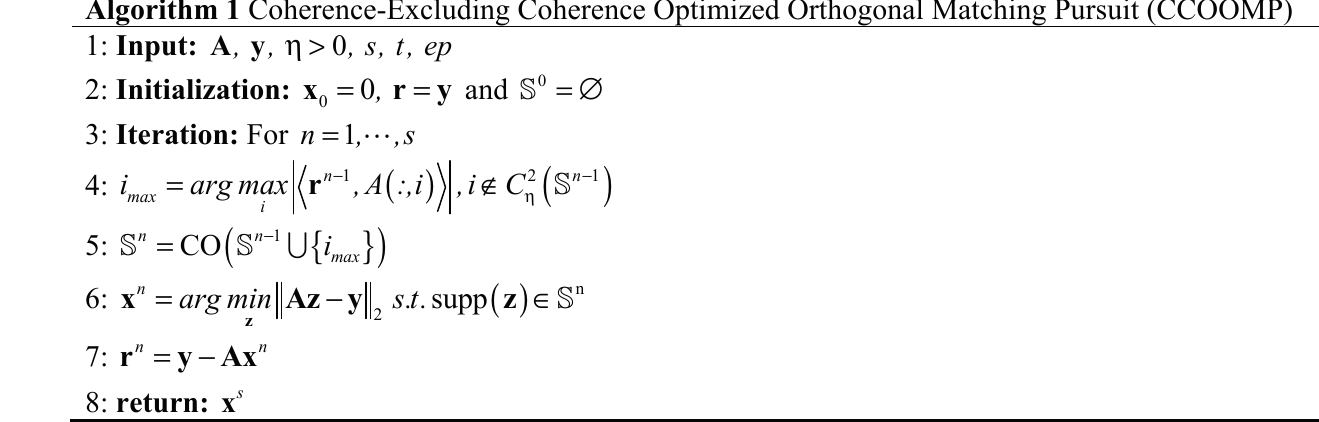
Algorithm 1 Coherence-Excluding Coherence Optimized Orthogonal Matching Pursuit